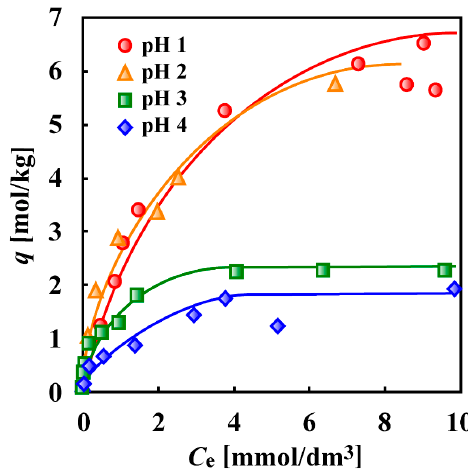
Figure 37. Temporal change in the Cr(VI), Cr(III), and total Cr concentrations at pH = 1 under the same conditions as shown for Figure 36 [35]. (With permission for reuse from Elsevier B.V.).